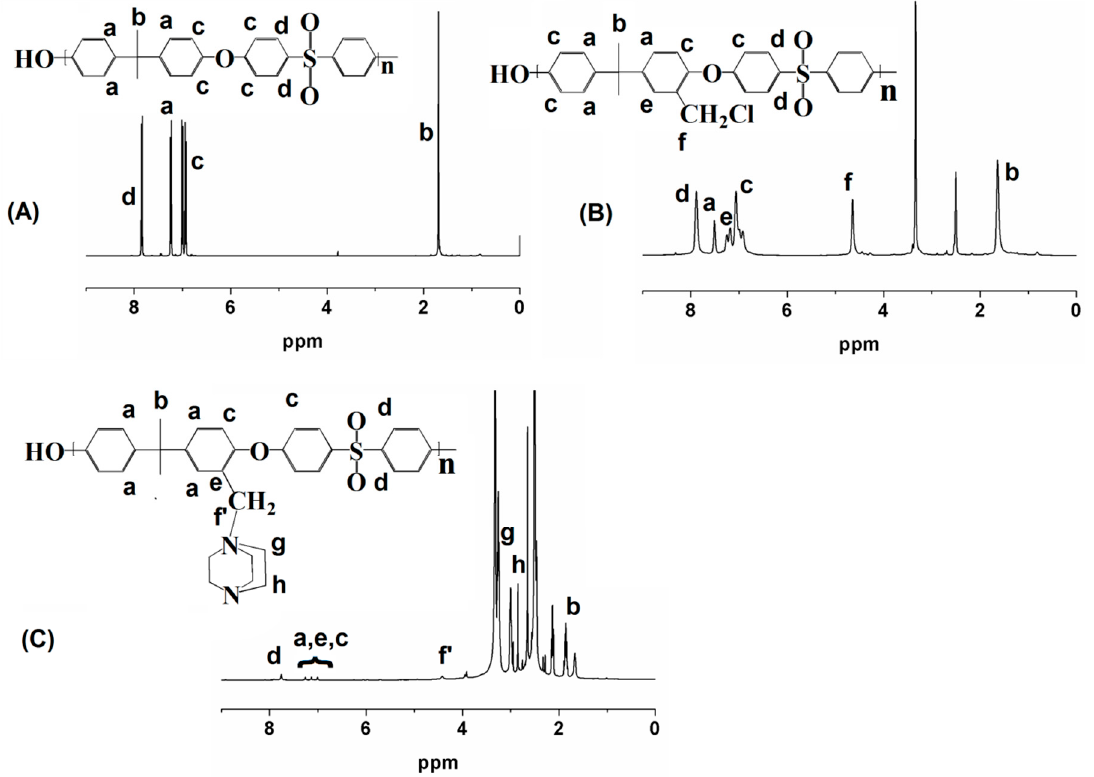
Figure 2. 1 H-NMR spectra ( A ) PSf, ( B ) ClPSf, and ( C ) Figure 2. 1 H - NMR spectra ( A ) PSf, ( B ) ClPSf, and ( C ) QPSf.